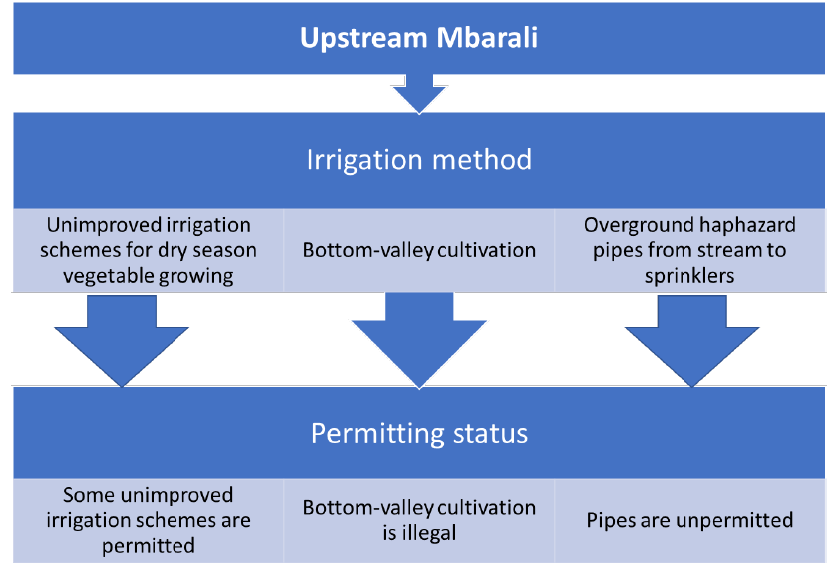
Figure 2. Permitting status by irrigation method in upstream Mbarali. Source: Produced by the author.